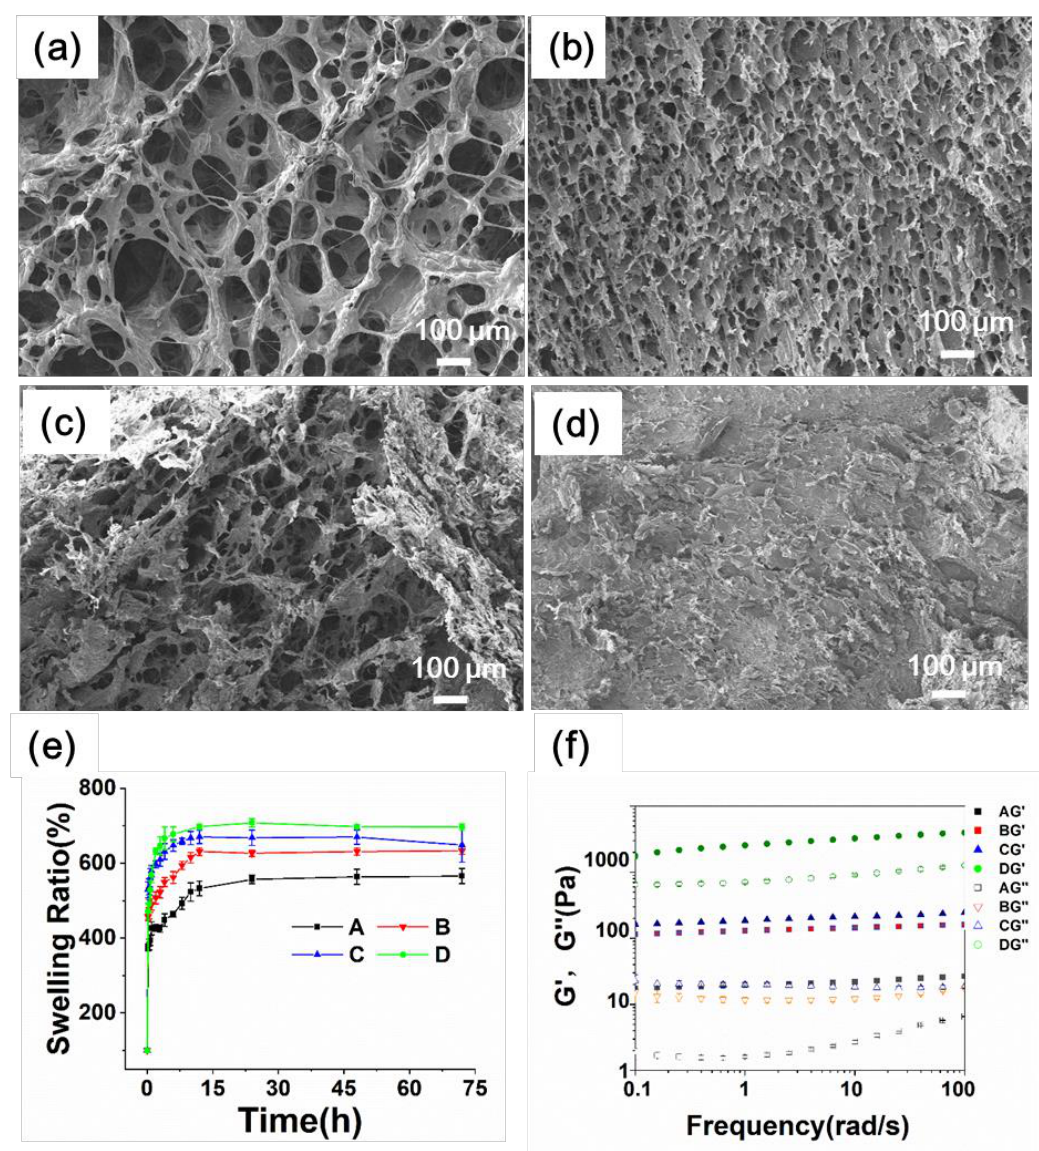
Figure 4. Characterization of the hydrogels. ( a – d ) SEM images of the hydrogels of A ( a ), B ( b ), C ( c ), and D ( d ). ( e ) The swelling behavior of the hydrogels. ( f ) Frequency-sweep dynamic rheological profiles of the hydrogels. profiles of the